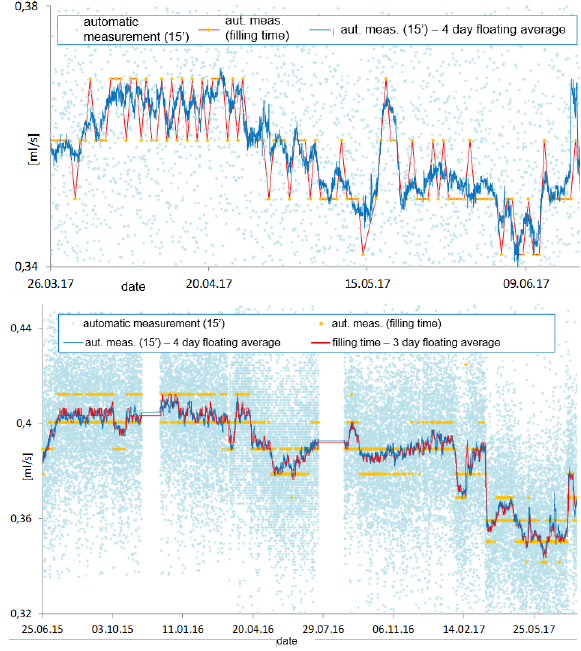
Fig. 11. Discharge level at W930. A comparison between con- tinuous water level measuring (blue dots) and filling time record- ing (yellow dots with red line). Up: 3-month period. Bottom: 2-year period.